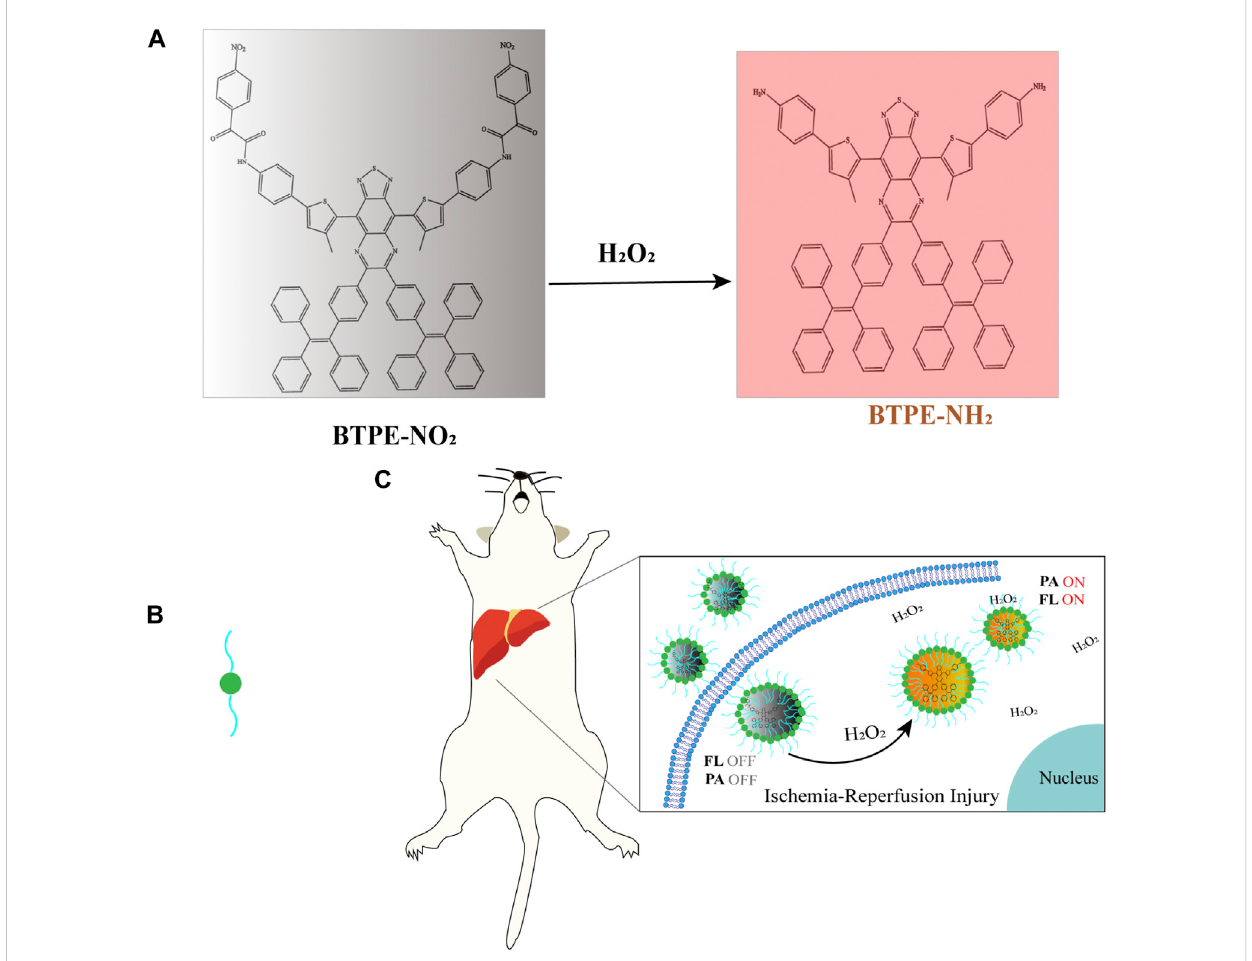
FIGURE 4 (A) The structure and luminescence mechanism of BTPE-NO 2 @F127 (Chen et al., 2021). (B) Represent the amphiphilic and biocompatible polymer Pluronic F127. (C) The H 2 O 2 -activating probe BTPENO 2 @F127 was used to image hepatic I/R injury in a mouse